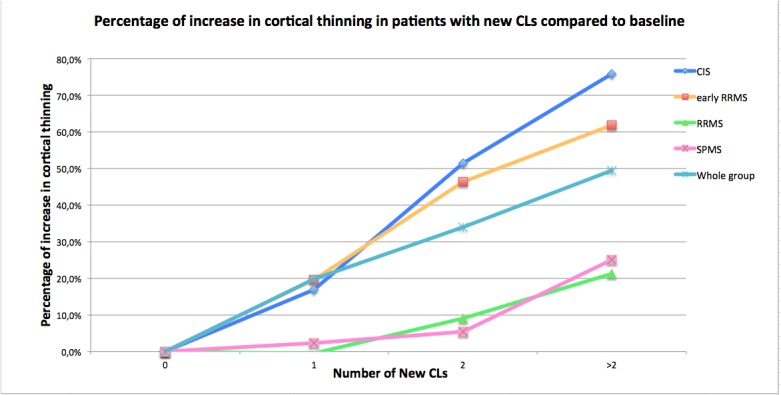
Relationship between the percentage of increase in cortical thinning and the appearance of new grey matter lesions during the 5-year follow up in the whole group and in the different MS subsets.As the image shows, patients with new cortical lesions showed higher cortical thinning; but this was more evident in CIS and early RRMS patients. The results are express as percentage of change from baseline, being the baseline the cortical thickness change when the number of new cortical lesions are 0.